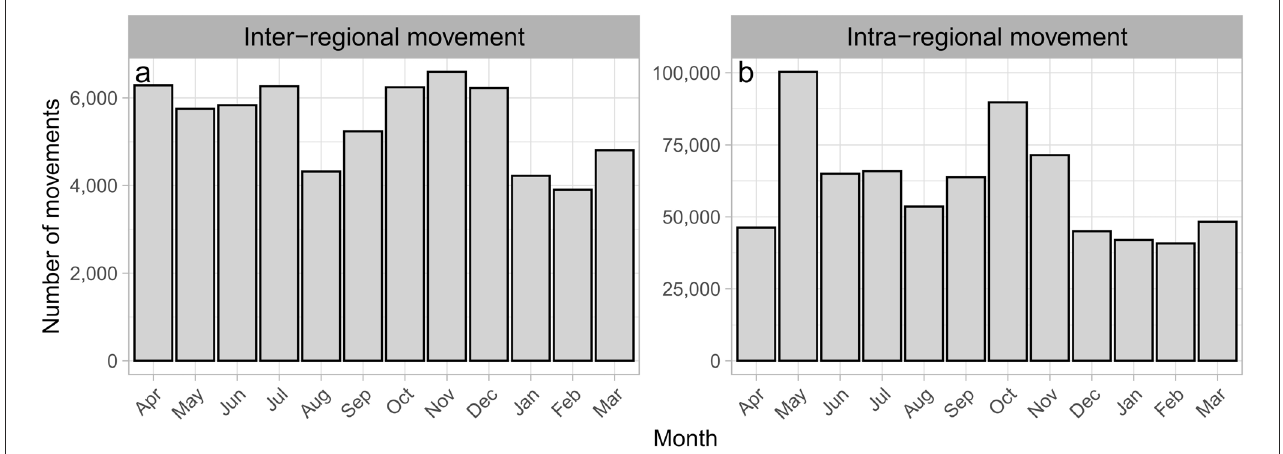
FIGURE3 Number of monthly movements of beef cows. Inter-regional (a) and intra-regional movements (b) of beef cows in Japan from FY2012 to FY2017.